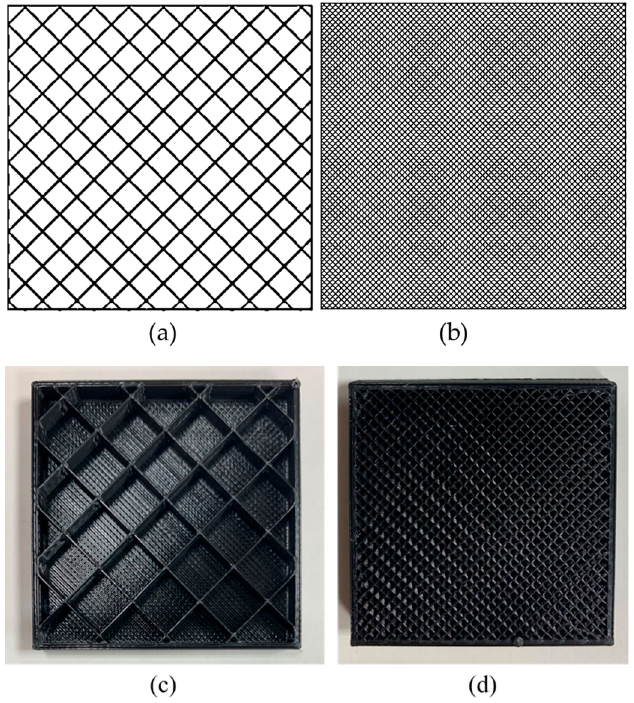
Figure 1. Schematic representation of the layups used for printing PLA and PF samples at an infill of ( a ) 10% and ( b ) 30% and related rendering for 3D printed PLA samples with a scale of 0.3 (45 × 45 × 9 mm) with ( c ) PLA-10% and ( d ) PLA-30% infill.